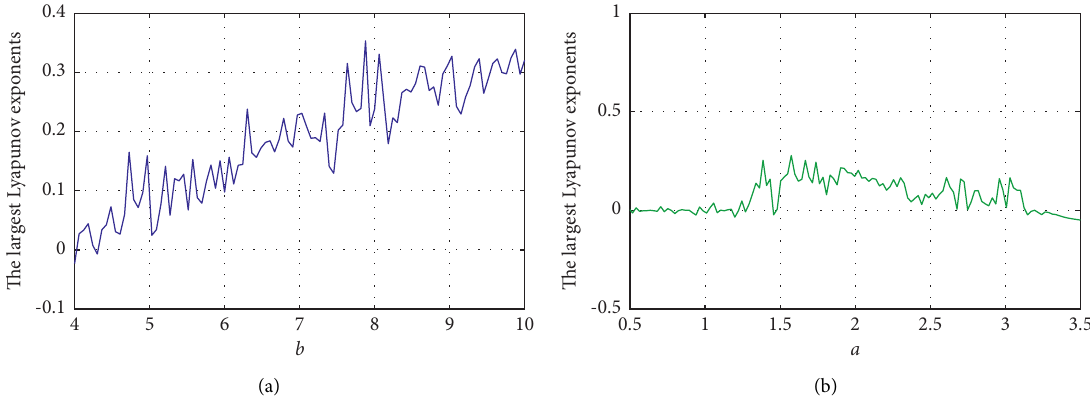
Figure 13: The largest Lyapunov exponents spectrum of the Rucklidge system with respect to different parameters.